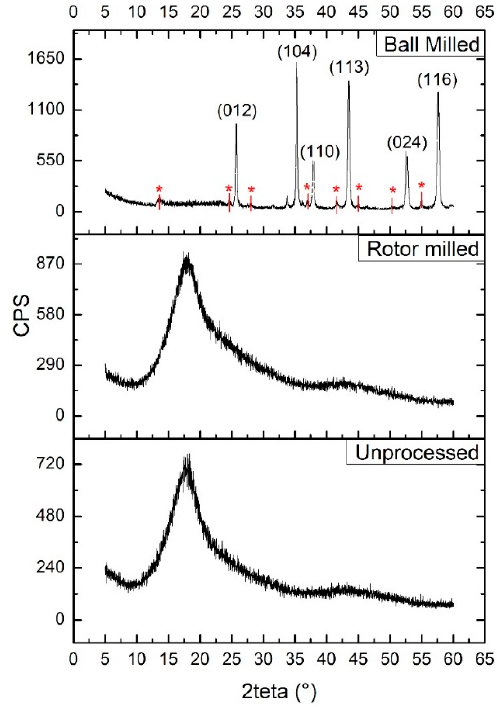
Figure 10. XRD diffractograms of the fine powder obtained after 10 min of ball milling, rotor milled powder subjected to the three step refinement process with additional sieving at 80 μ m, and unprocessed PSU pellets. Small peaks marked with an asterisk are believed to be attributed to the orientation induced in PSU by the milling method.